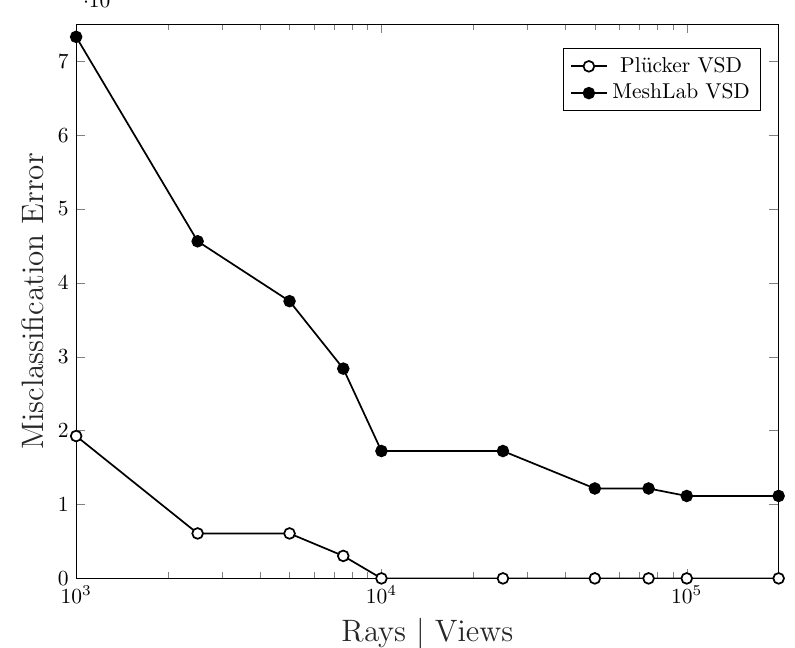
Figure 18. Convergence comparison of the misclassification error using the two algorithms on Sample